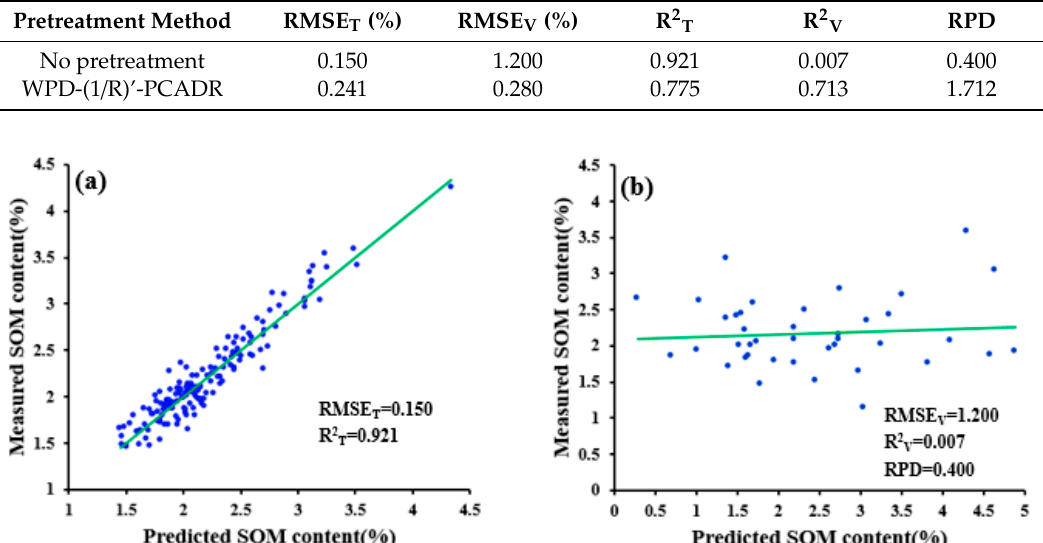
Table 5. SOM Content Estimation Model Results Based on PLSR Model in the Case of Untreated Data and Those Subjected to Optimal Pretreatment.